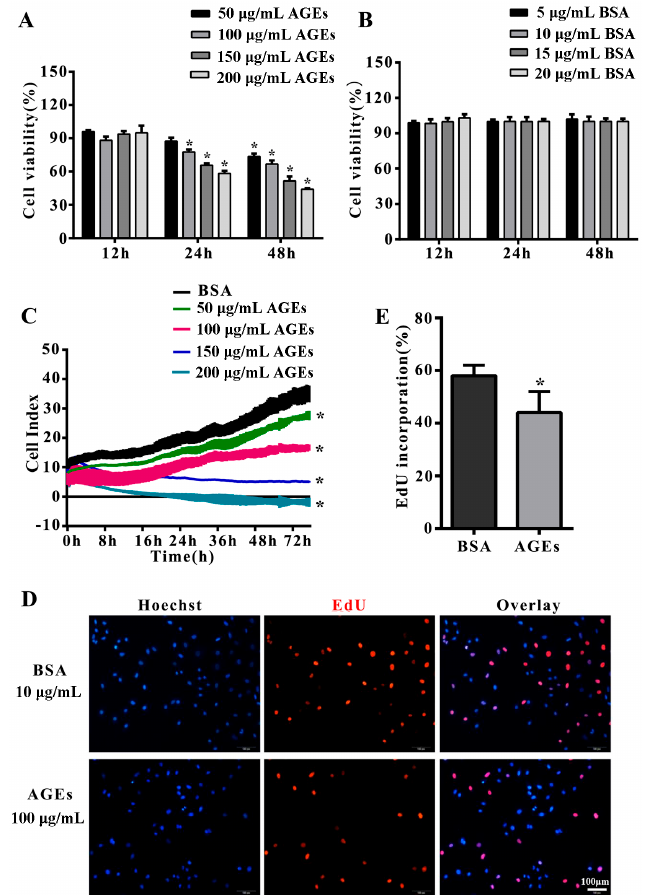
Figure 1. Advanced glycation end products (AGEs) inhibited the proliferation of human umbilical vein endothelial cells (HUVECs). Cells were incubated with different concentrations of AGEs (50, 100, 150 and 200 µg/mL) or different concentrations of bovine serum albumin (BSA) (5, 10, 15 and 20 µg/mL) as control for different times (12, 24 and 48 h). ( A , B ) Cell proliferation was detected by Methyl thiazolyl tetrazolium (MTT) assay (* p < 0.05 vs. BSA group at corresponding concentration and the same time-point); ( C ) Cell proliferation was monitored by a real-time cell analyzer (RTCA) dynamically. Cell index was recorded automatically every 15 min intervals and monitored continuously for 48 h (* p < 0.05 vs. BSA group); ( D ) Cell proliferation was also detected by 5-Ethynyl-2 ′ -deoxyuridine (EdU) staining assay, in which the red dots represented the population of newborn cells. Hoechst 33342 staining (blue dots) was used to label cell nuclei; ( E ) Three microscopic fields were randomly selected. EdU incorporation (%) was quantified by Image J 1.47, which was calculated by the formula: EdU incorporation = cells stained by red/(cells stained by red + cells stained by blue) × 100% (* p < 0.05 vs. BSA group). All data were obtained from reproducible experiments ( n = 3).